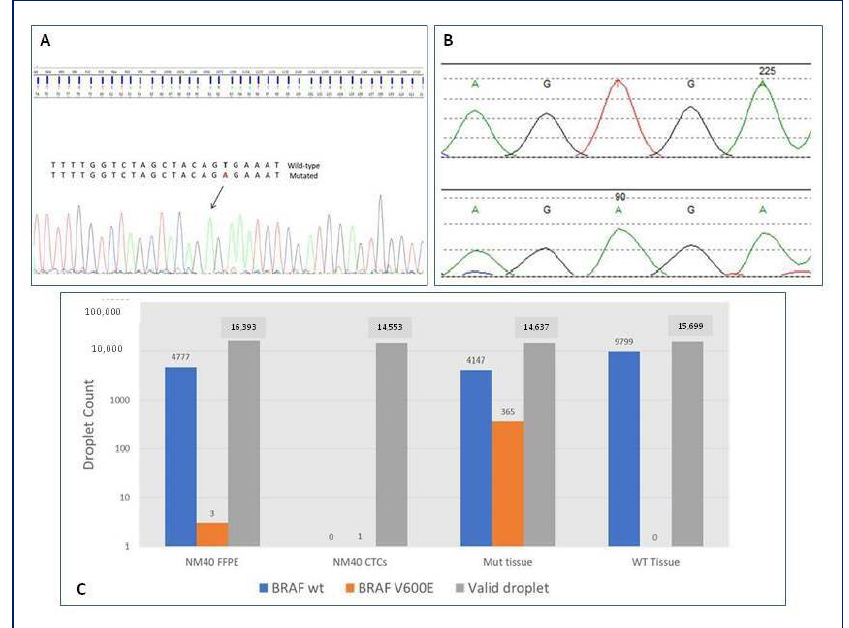
Figure 6. BRAF status on CTCs and tissue biopsy of adenocarcinoma patient. ( A ) Sanger sequencing on microdissected CTCs revealing mutation at the level of T1799A, leading to the substitution of valine for glutamic acid (V600E). ( B ) NGS analysis on tissue biopsy revealing 2 out of 31 reads of the BRAF gene showing the mutated allele at position chr7.140453136 A > T (V600E). ( C ) Digital PCR performed for both the tissue biopsy and CTCs showing the mutated allele at position chr7.140453136 A > T (V600E). BRAF, v-raf murine sarcoma viral oncogene homolog B; CTCs, circulating tumor cells; NM40, patient identification number; GTG > GAG, substitution of valine for glutamic acid; Mut, mutated; WT, wild-type; FFPE, Formalin-Fixed Paraffin-Embedded tissue; NGS, next generation sequencing; PCR, polymerase chain